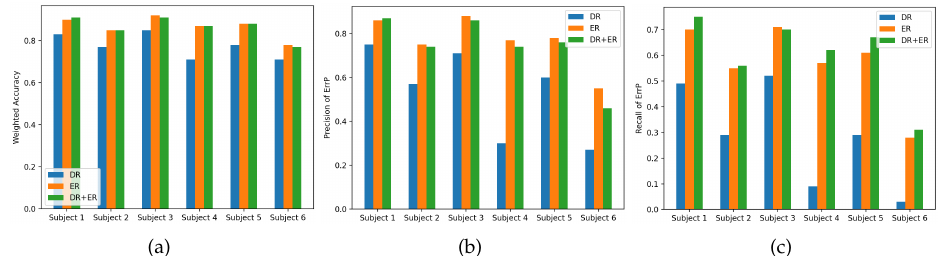
Figure 9. Comparison of the classification performance of Epoch–Riemann vector (noted as ER) and the PVD–Riemann vector (noted as PR) on the data of each session of each subject. (Average results of 10-fold cross-validation are reported.) ( a ) Weighted accuracy. ( b ) Precision. ( c )